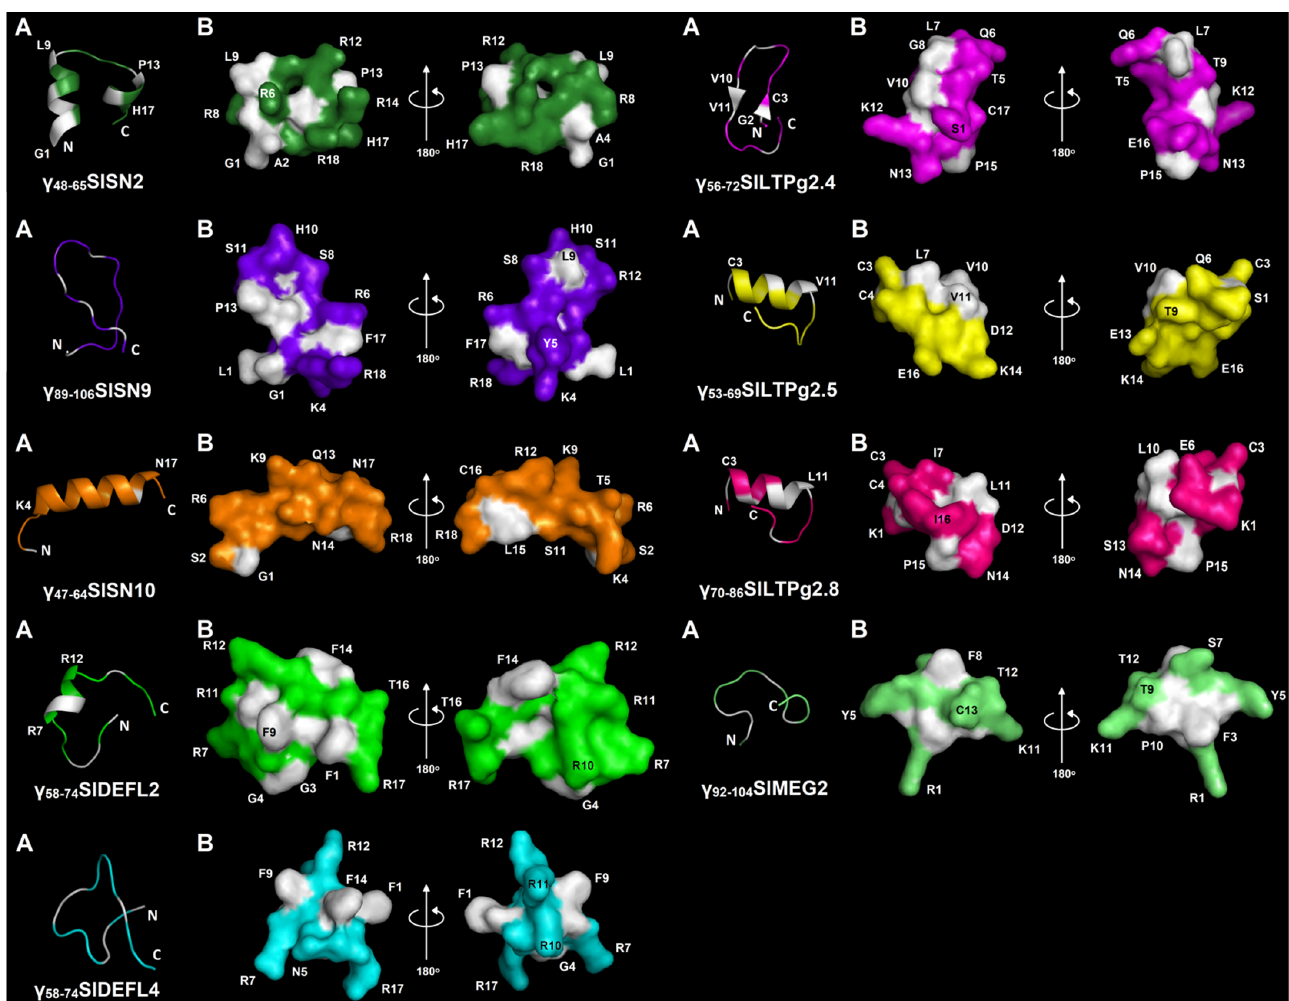
Figure 2. 3D molecular modeling of synthetic peptides: ( A ) spatial structure (ribbon representation); ( B ) surface structure. N- and C-termini are marked with N and C, respectively. Non-polar residues are shown in white, polar residues are colored. Modeling was performed using PEP-FOLD3 [14].